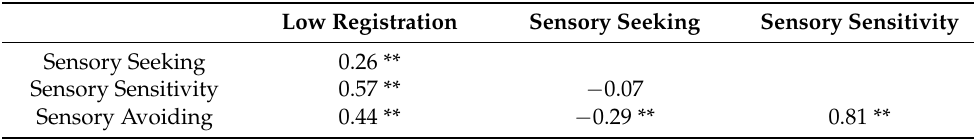
Table 2. Pearson’s correlation coefficients between AASP raw quadrant scores. Low Registration Sensory Seeking Sensory Sensitivity Sensory Seeking 0.26 ** Sensory Sensitivity 0.57 ** − 0.07 Sensory Avoiding 0.44 ** − 0.29 ** 0.81 ** ** p <